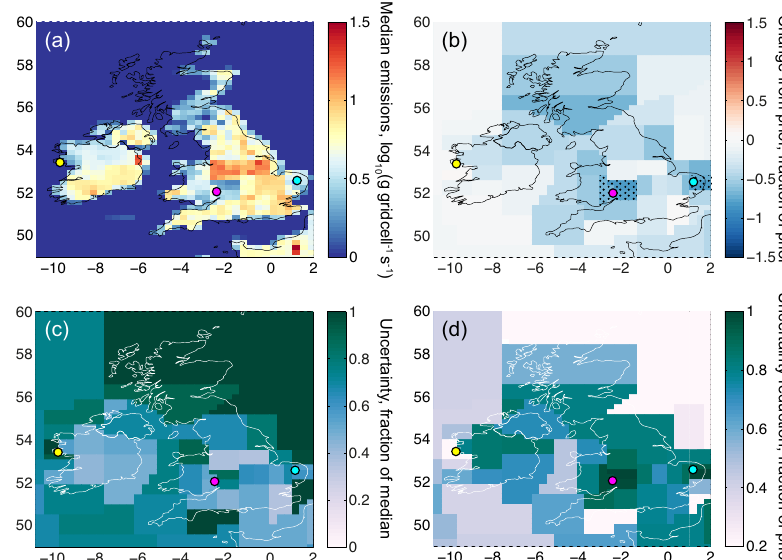
Figure 5. Same as Fig. 4 but for N 2 O.